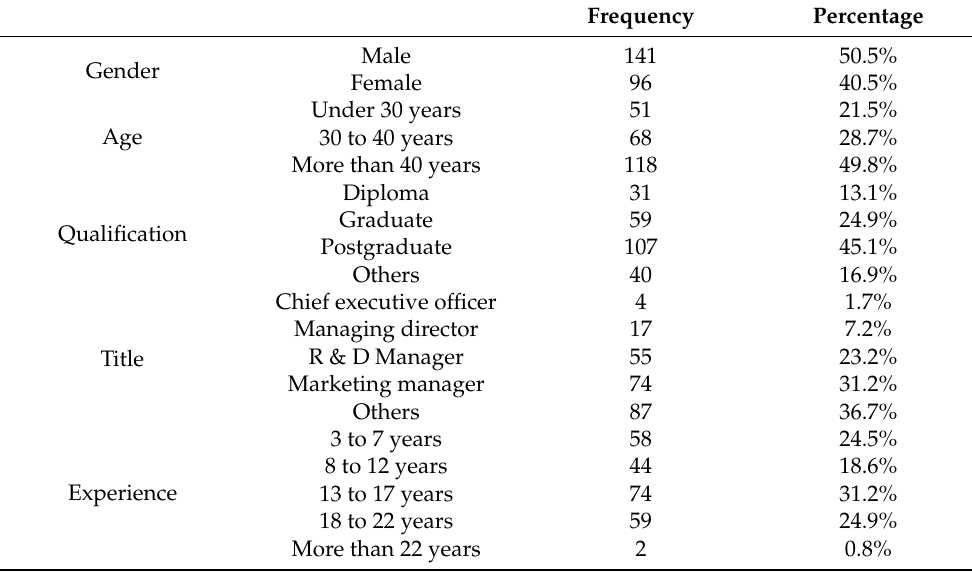
Table 2. Participants’